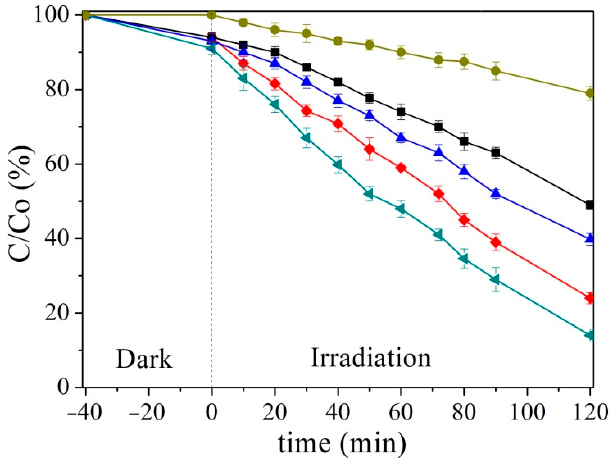
Figure 7. Decoloration of methylene blue (MB) in the absence of a photocatalyst ( • ) and in the presence of parent ZnO–TiO 2 core-shell flowers ( ◼ ) and ZT-rGO at 0.5 ( ◆ ), 2 ( ◀ ), and 5 wt % ( ▲ ) rGO.